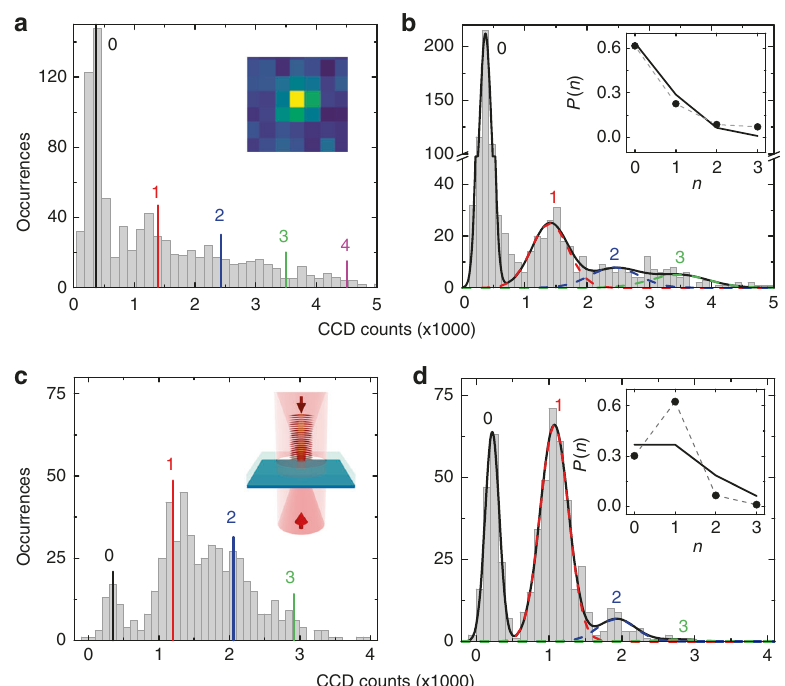
Fig. 2 Single atom loading and fl uorescence counting on a nanostructure. a , b Histograms of fl uorescence counts within a single tweezer trap (inset) on the nanostructure as shown in Fig. 1, recorded in two consecutive imaging periods that are separated by a 40 ms dark time. c , d Histograms of fl uorescence counts for trapping in a tweezer lattice on a membrane, recorded in the two imaging periods. Here, a phase coherent, counter-propagating dipole beam is added to form an optical lattice within the tweezer trap (inset); for potential curves, see Fig. 3. Single-atom fl uorescence peaks in both cases manifest in the second imaging period. In b , d composite Gaussian fi ts (black solid curves) indicate the count distributions of n = 0, 1, 2, ... trapped atoms (color dashed curves) and their averaged count contributions (vertical lines in a , c ). Inset in b ( d ) shows the fi tted probability P ( n ) of trapping n atoms (circles) in a tweezer lattice and a Poisson fi t (solid lines) with (cid:1) n ¼ 0 : 45 (cid:1) n ¼ 1 ð